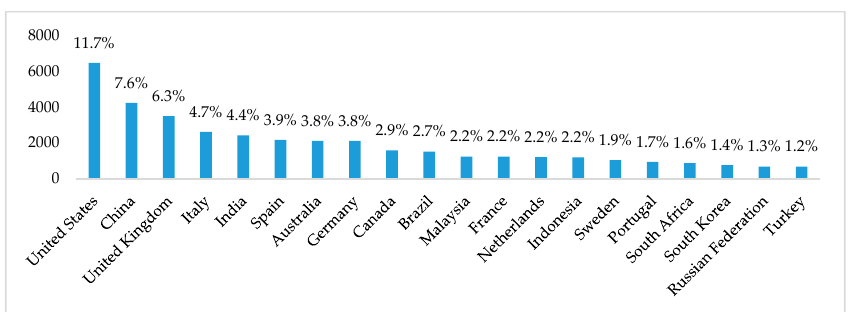
Figure 6. Articles published on sustainability between 2019 and 2020.